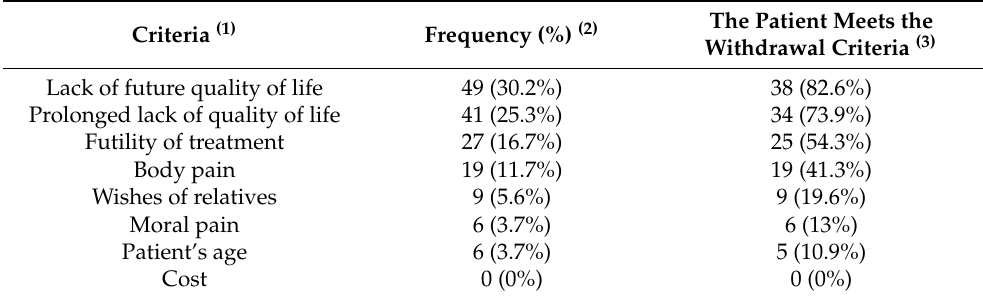
Table 2. Intensivists’ criteria for withdrawal or non-escalation of support